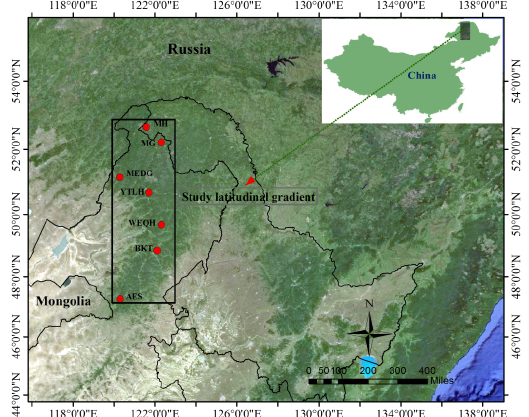
Figure 1. Map showing the locations in China where Larix gmelinii tree-ring samples were collected (red-filled circles). Abbreviations for our sampling sites are AES (Aershan), BKT (Boketu), WEQH (Wuerqihan), YTLH (Yitulihe), MEDG (Moerdaoga), MG (Mangui), and MH (Mohe).